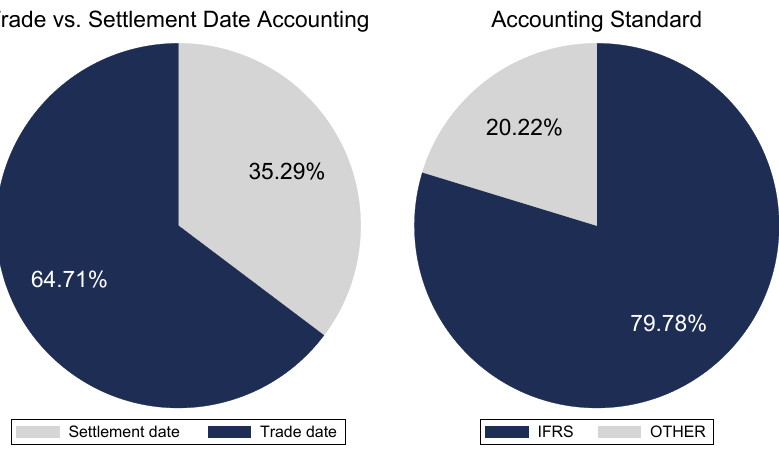
Figure 3. Accounting standards and the use of trade date accounting. The graph on the right (Trade vs. Settlement Date Accounting) shows the percentage of MTS participants that use trade date and settlement date accounting. In the graph, banks are weighted with their total assets held for trading (based on data from SNL Financial). The information of whether a firm uses trade date or settlement date accounting was hand-collected from 2016 annual reports. The considered MTS participants are all those that appeared in a snapshot of the member list on the MTS website taken on 21 November